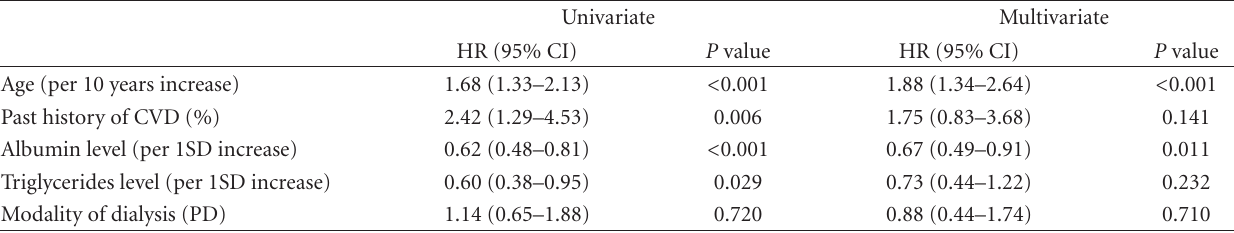
Table 2: Hazard ratios for clinical parameters derived by Cox proportional hazard